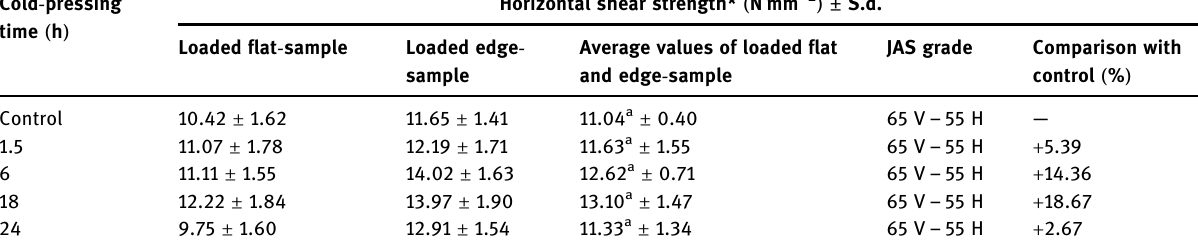
Horizontal shear strength* ( N mm − 2 ) ± S.d.